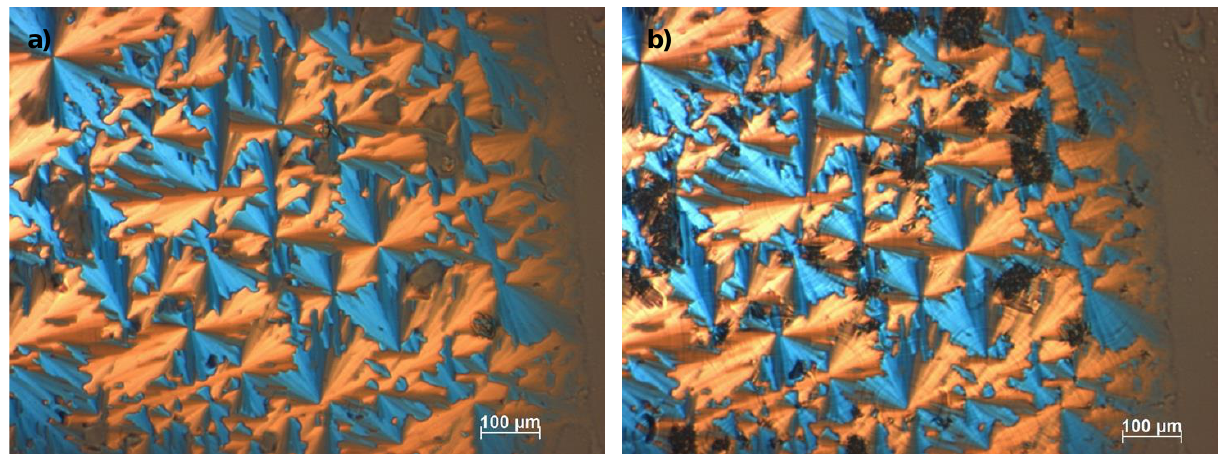
Figure 3. Optical textures of [Ph-Tri-(16) 2 ][OTf] ( a ) at 92 ◦ C and ( b ) 67 ◦ C. Images observed by polarized optical microscopy analysis under crossed polarizers showing ( a ) the mesophase after the first transition from the isotropic liquid to the liquid crystalline phase and ( b ) the LC-LC transition upon cooling with 5 ◦ C min − 1